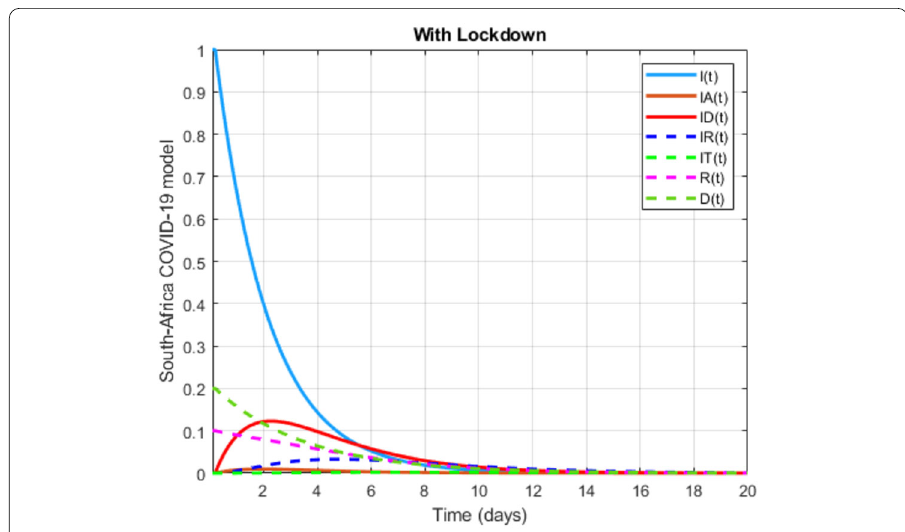
Figure 34 Numerical visualization for Covid-19 model in South Africa